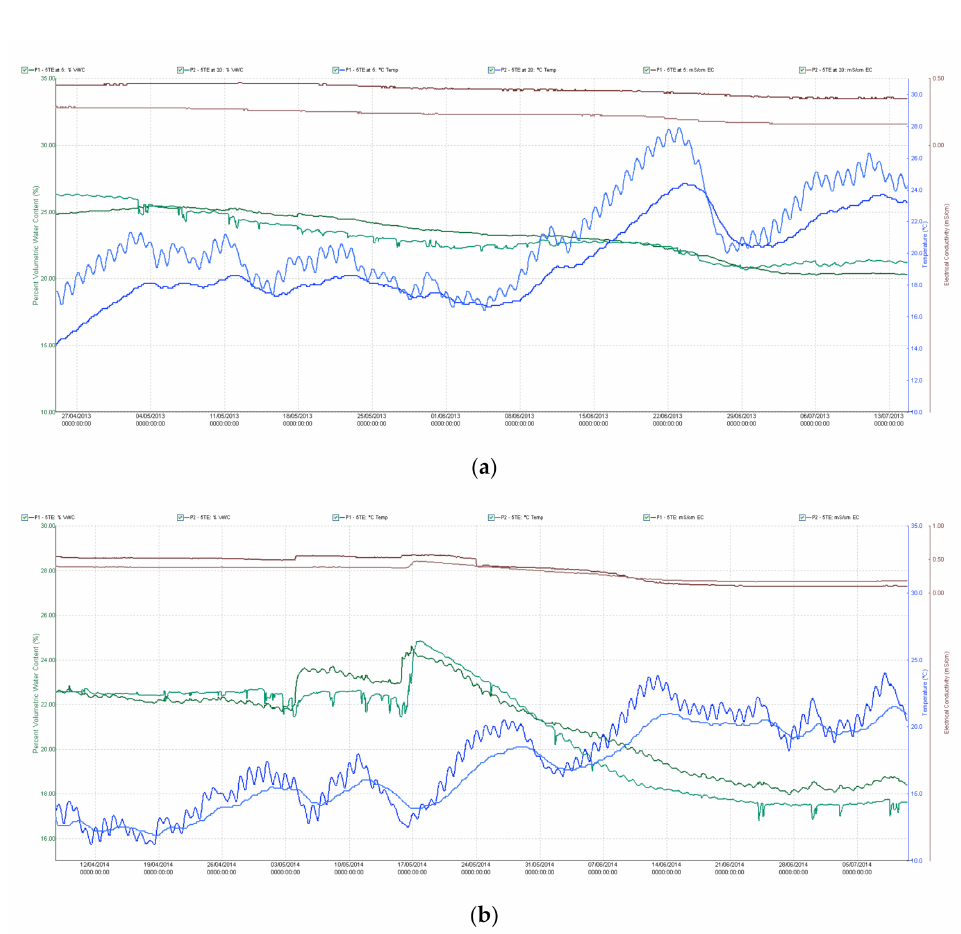
Figure A1. ( a ) Trends in soil moisture content, soil temperature and electrical conductivity at depths of 30 and 60 cm in the rain-fed plots ( a ) 2013 growing season; ( b ) 2014 growing